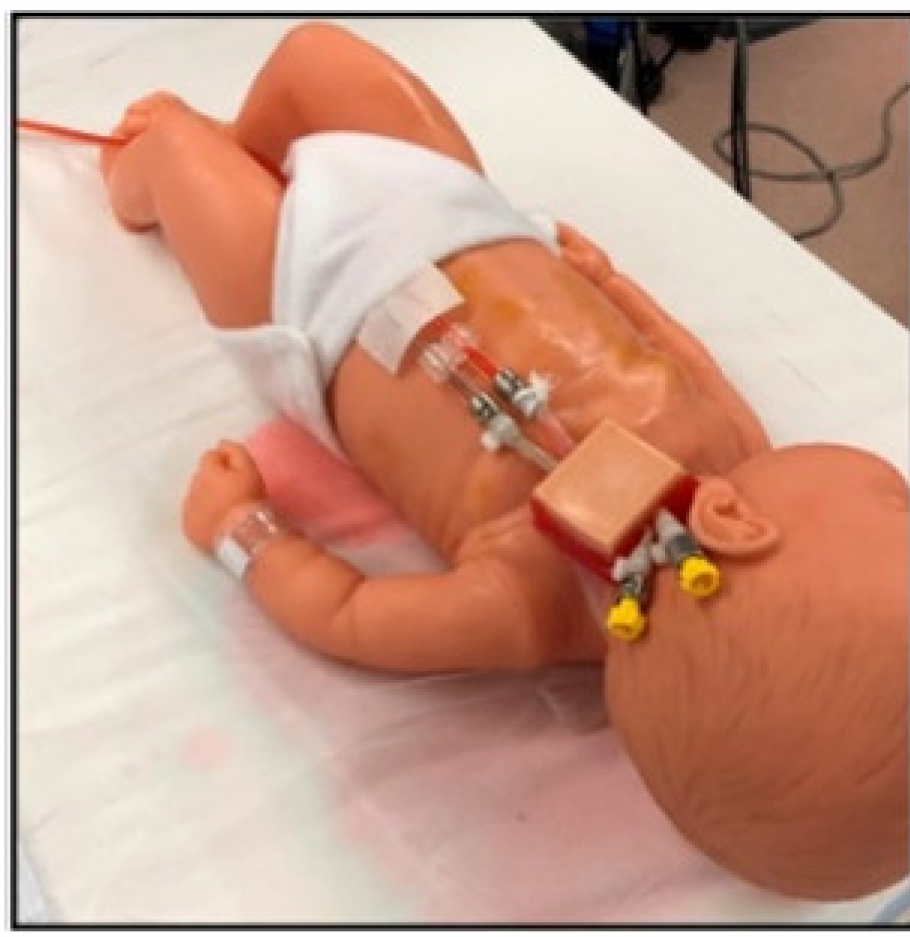
Figure 4. Neonatal ECMO cannulation simulator